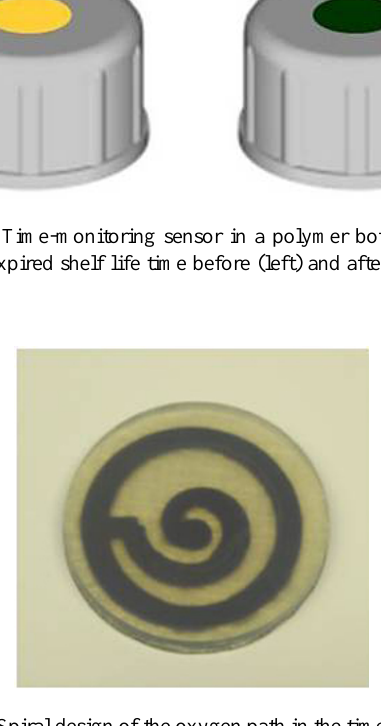
Figure 15. Spiral design of the oxygen path in the time-monitoring